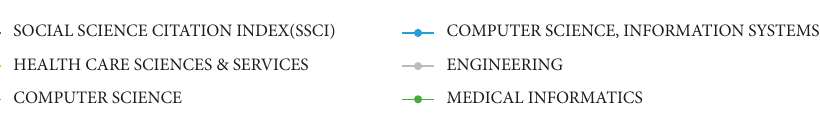
Figure 7: Top 6 disciplines of international DEM research in 2000–2022.